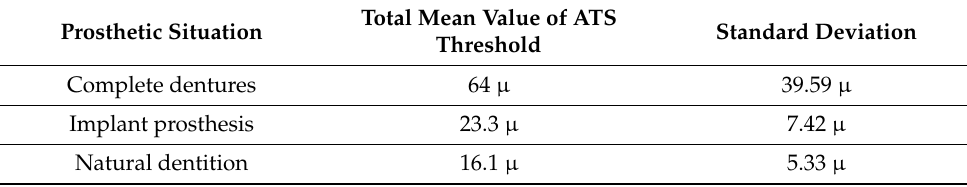
Table 5. Total means values of active tactile sensibility